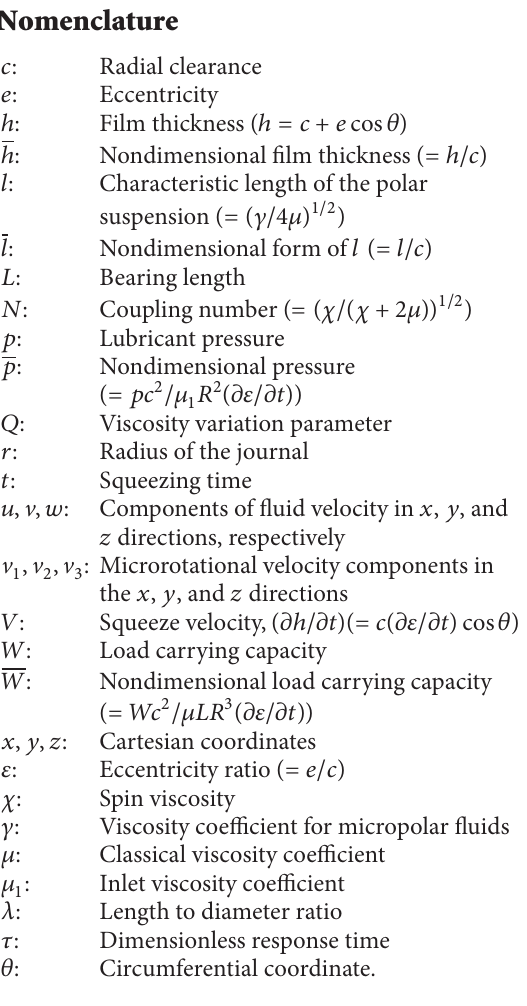
Newtonian case by which the performance of squeeze film in journal bearings